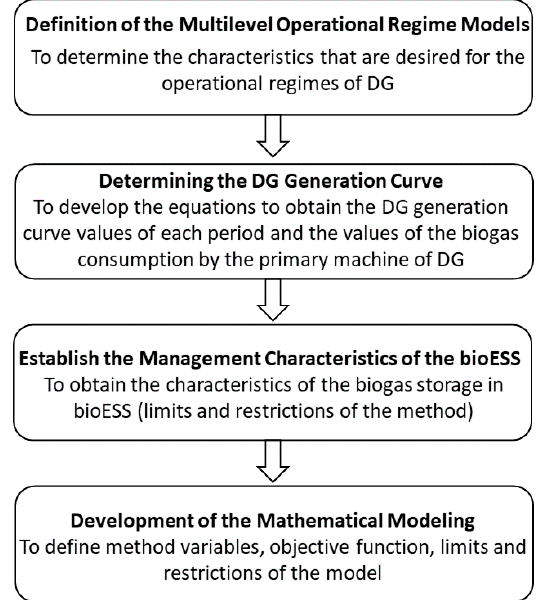
Figure 2. Steps for the development of the proposed methodology.